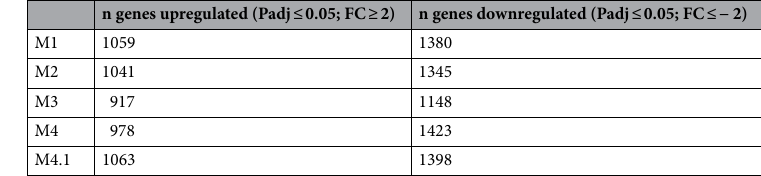
Table 2. Number of differentially expressed (up-and downregulated) genes in the different M-stages in comparison to healthy skin tissue. The fold change (FC) and adjusted p-value (Padj) threshold are shown between brackets. The fold change threshold is set at ≥ 2 for upregulated genes and ≤ − 2 for downregulated